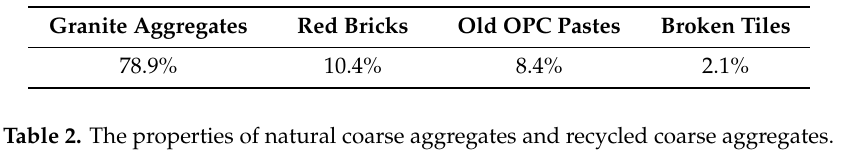
Table 1. The proportions of components in recycled aggregates.